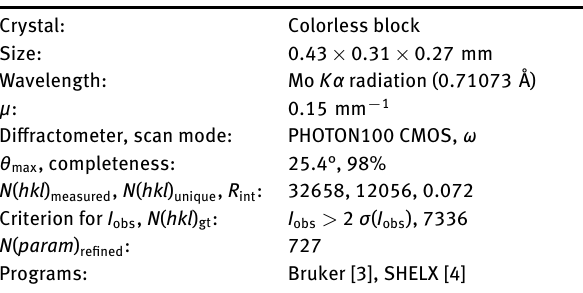
Table 1: Data collection and handling.